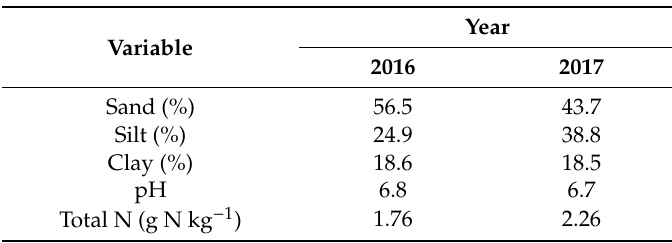
Table 1. Main soil characteristics of the experimental